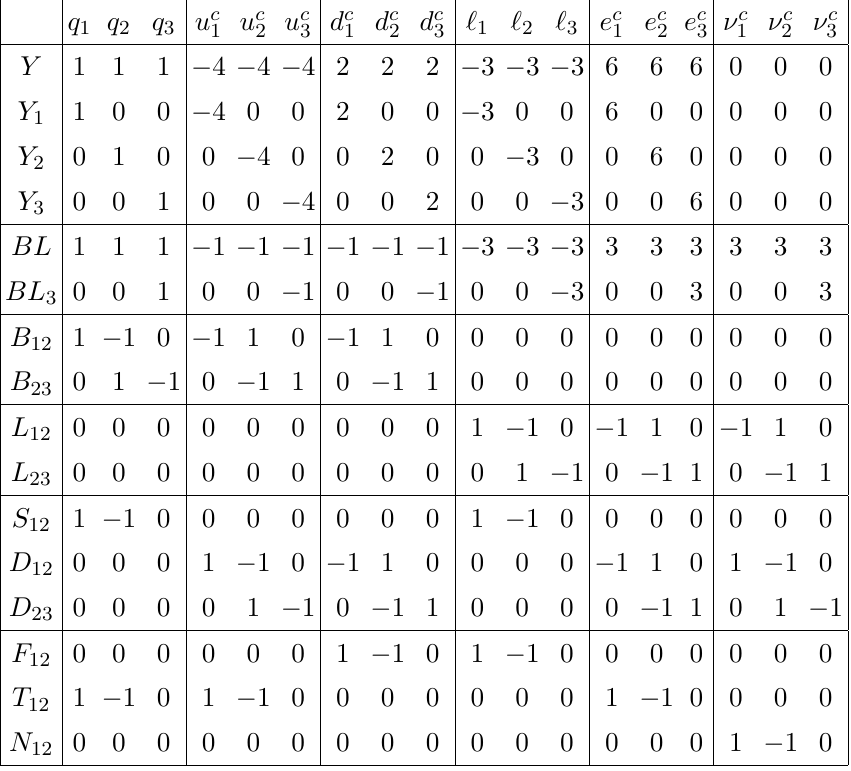
Table 3 . Charges of the SM +3 ν R fermions under a set of u (1) X symmetries that play a central role in this paper. Namely, every possible sm ⊕ u (1) gauge model that embeds inside a semi-simple g X can be expressed as a linear combination of a particular subset of these rows (that we determine), up to family permutations within each species. Here ‘ B ’ and ‘ L ’ stand for baryon and lepton as usual, ‘ Y ’ stands for (global) hypercharge , ‘ S ’ stands for sinistral (meaning left-handed), ‘ D ’ stands for dextral (meaning right-handed), ‘ F ’ stands for five , ‘ T ’ for ten , and ‘ N ’ for neutrino